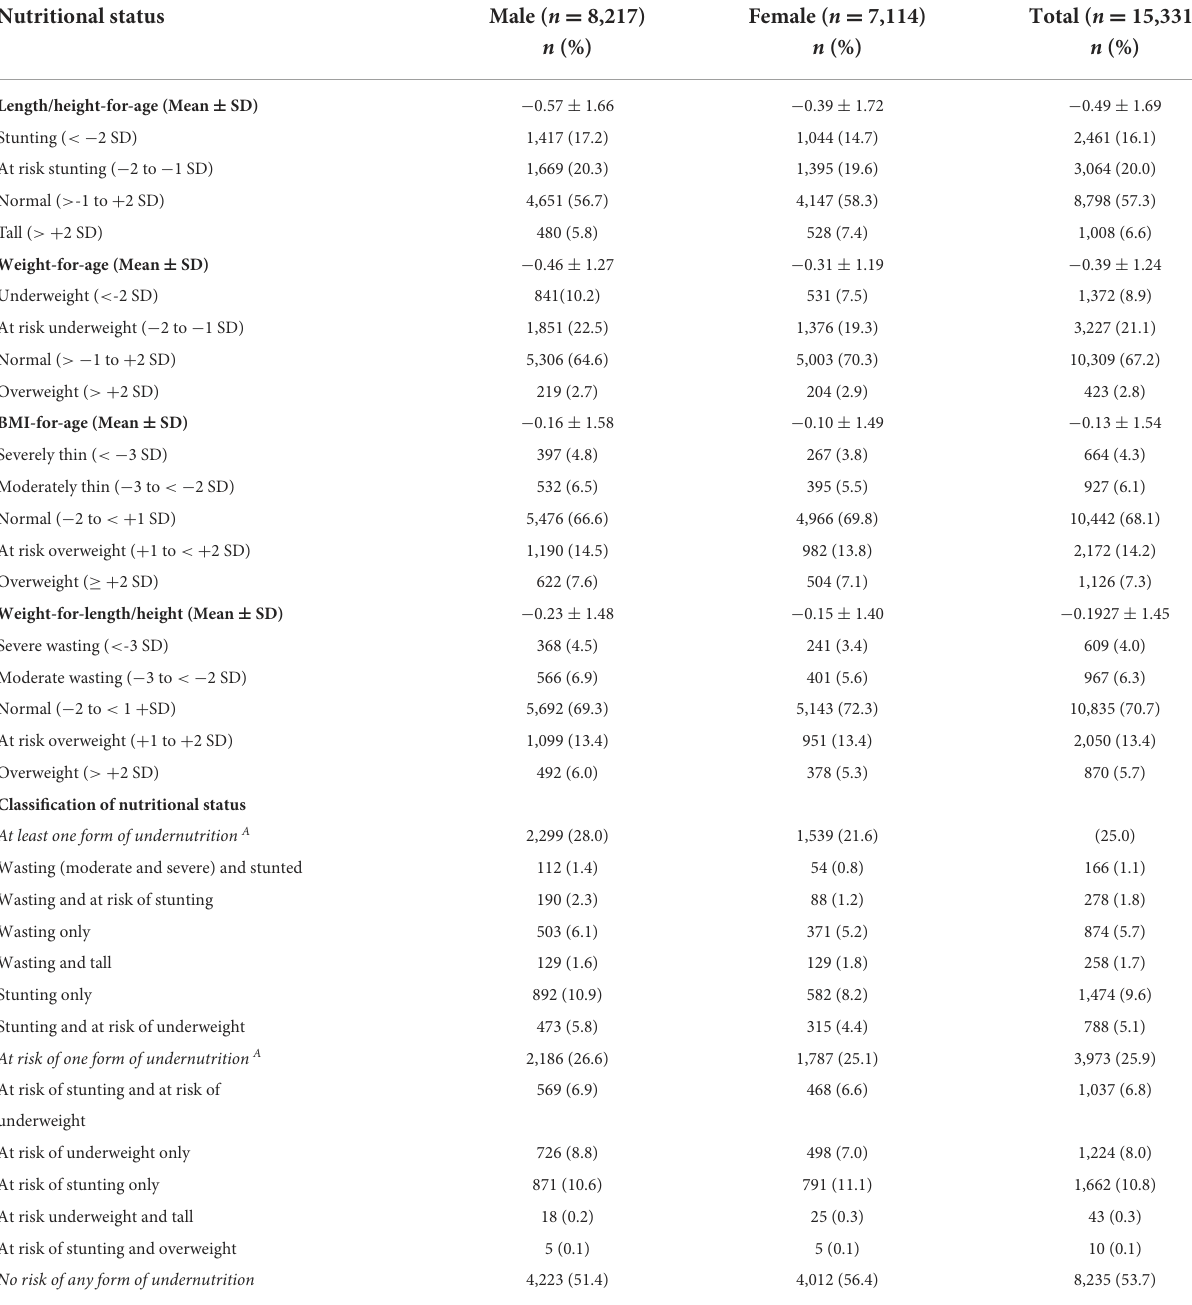
TABLE 1 Classification of growth status of 15,331 Malaysian children aged 1 to 5